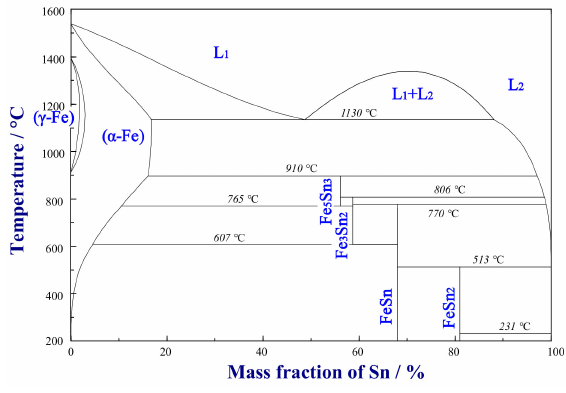
Figure 1. Fe–Sn binary alloy phase diagram